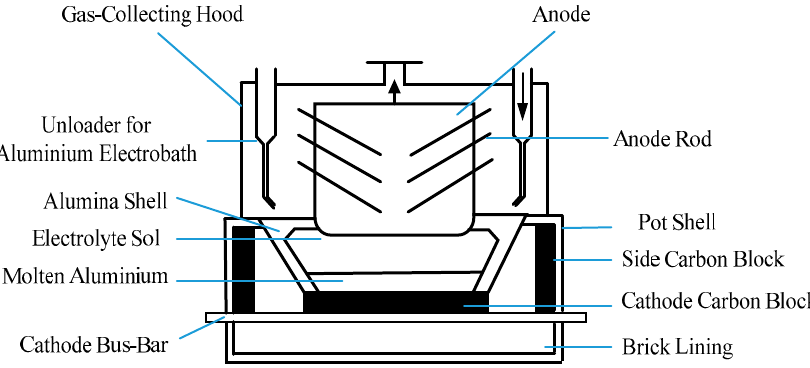
Figure 2. The internal structure of the aluminum electrolytic cell.